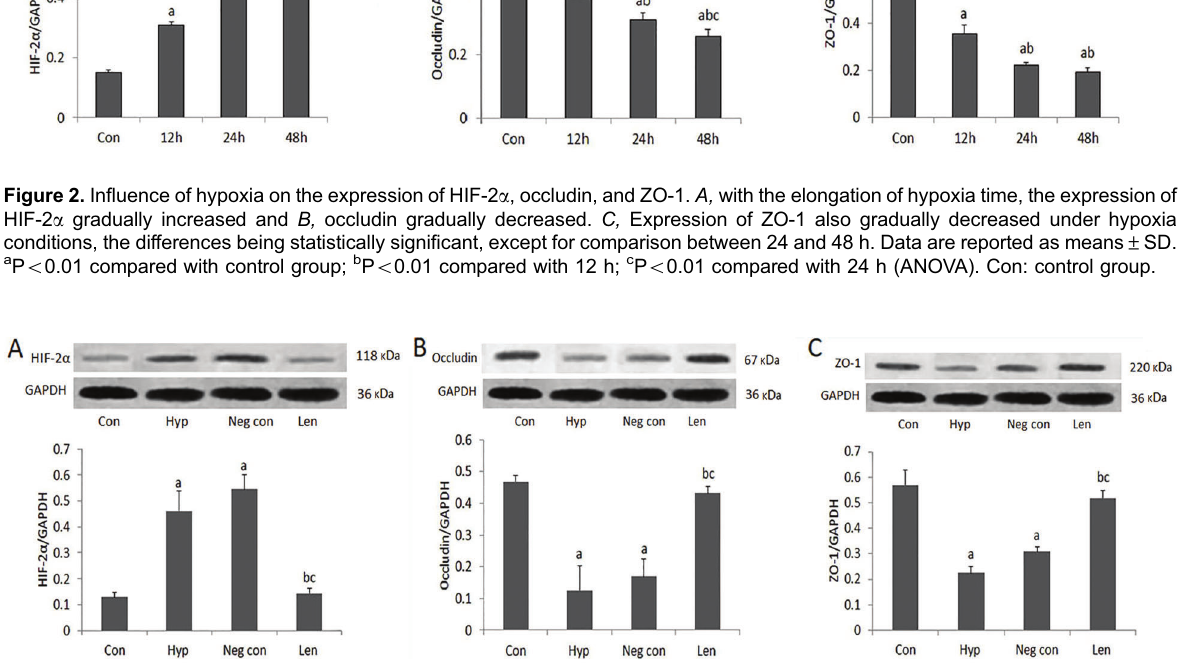
Figure 3. A, Hypoxia led to HIF-2 a increase in cells, except in cells transfected with HIF-2 a -shRNA. B, After infection with HIF-2 a - shRNA, the expression of occludin signi fi cantly increased in rat glomerular endothelial cells (rGENCs). C , The expression of ZO-1 under hypoxia conditions also increased. Data are reported as means ± SD. Con: control group, rGENCs were cultured under 20.9% O 2 (n=3); Hyp: hypoxia group, rGENCs were cultured under 5% O 2 (n=3); Neg con: negative control group, rGENCs were infected with HIF-2 a lentivirus negative control vectors and cultured under hypoxic conditions (n=3); Len: HIF-2 a lentivirus transfected group, rGENCs were transfected with HIF-2 a lentivirus and cultured under hypoxic conditions (n=3). a P o 0.01 compared with control group; b P o 0.01 compared with hypoxia group; c P o 0.01 compared with Neg con group